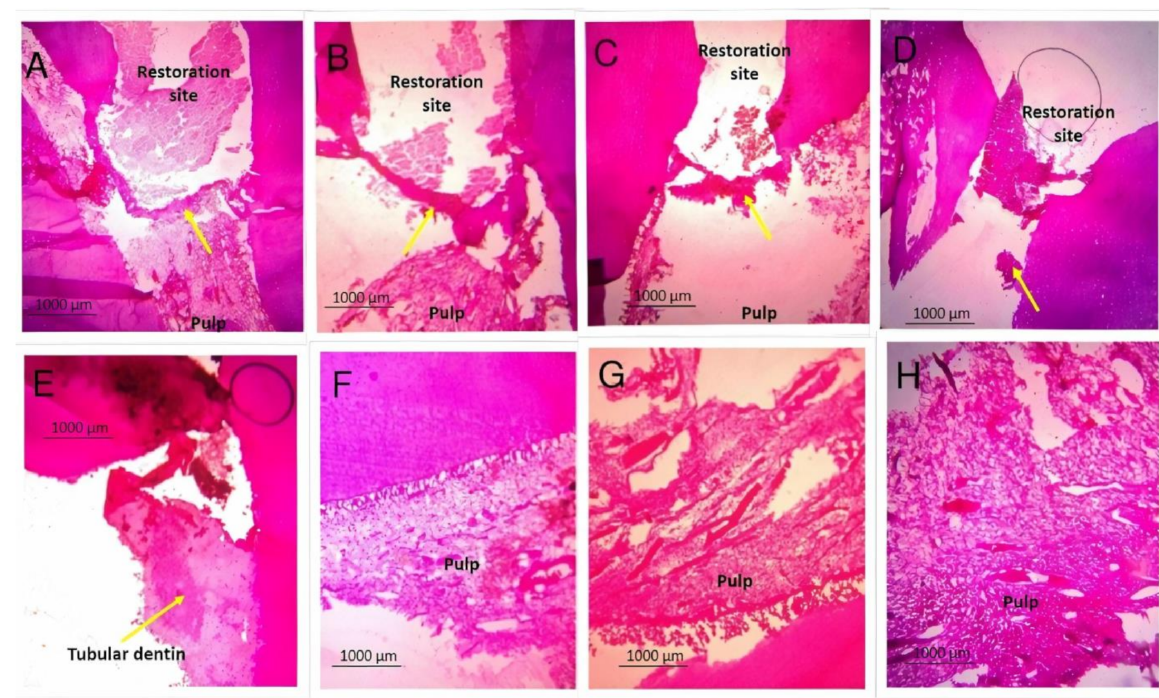
Figure 4. ( A ) Complete dentinal bridge (yellow arrows) in EndoSequence root repair material (ERRM)-treated tooth; ( B ) complete dentinal bridge in MTA-treated tooth; ( C ) complete bridge in Biodentine-treated tooth with dentin-like mass; ( D ) incomplete amorphous bridge in calcium hydroxide treated teeth (4 × , H and E stain); ( E ) magnified view of tubular dentin in the dentinal bridge; ( F ) dental pulp with no inflammation; ( G ) mild inflammation; ( H ) moderate inflammation (10 × , H and E stain).